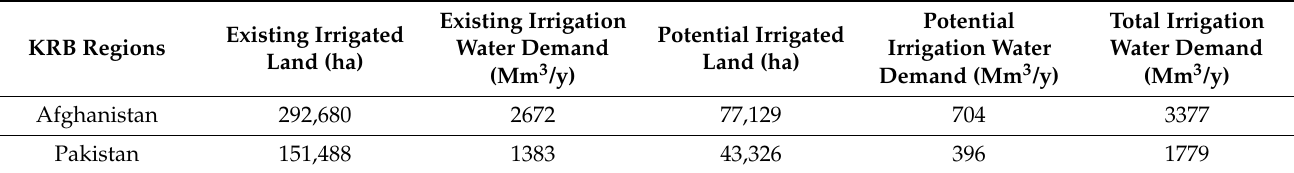
Table 4. Existing and future irrigation water demands in the KRB (Afghanistan and Pakistan).